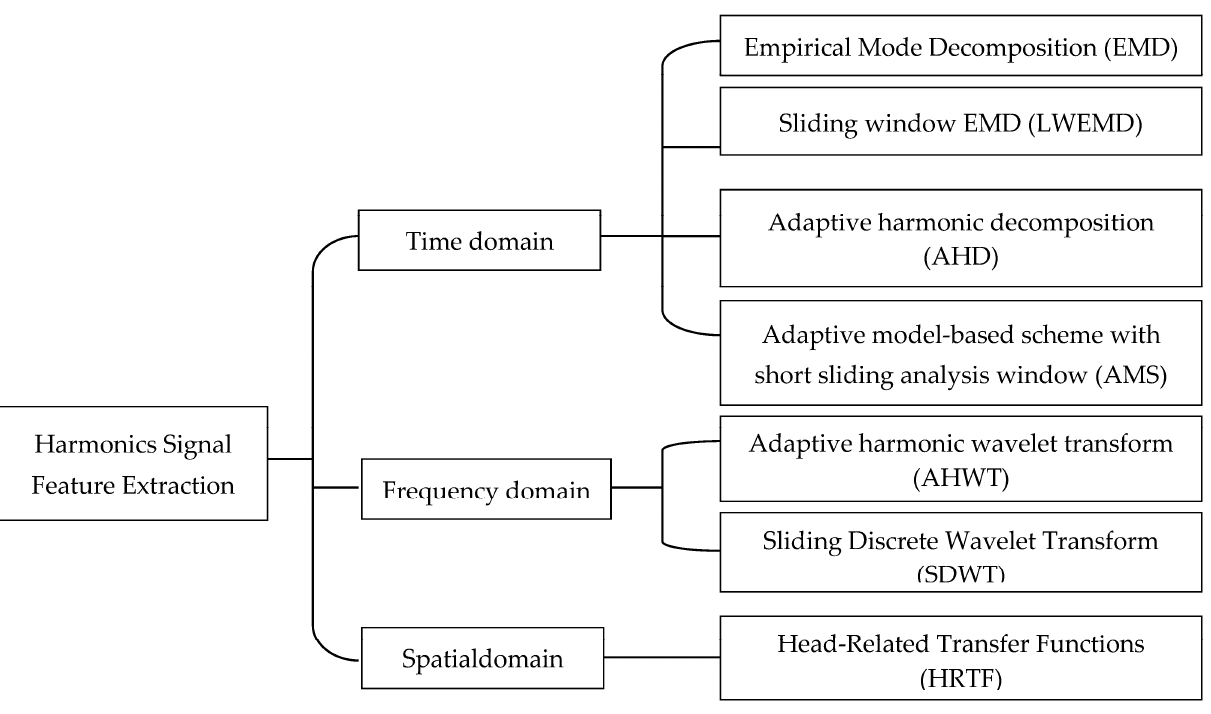
Figure 5. Harmonics Signal Feature Extraction techniques .